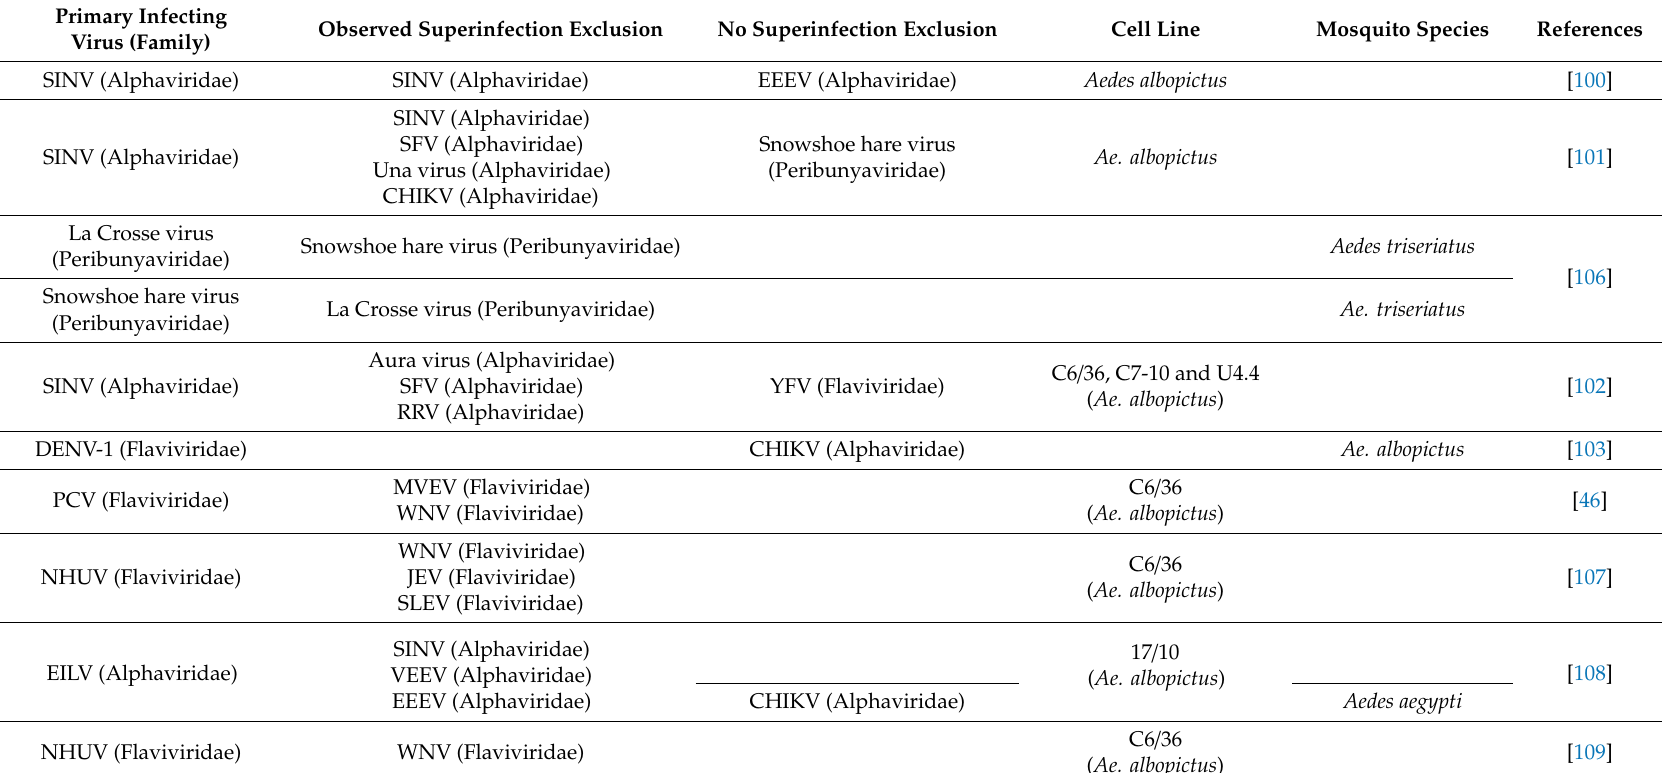
Table 1. List of published papers reporting superinfection exclusion and co-infection phenomena in Aedes mosquito cells and Aedes mosquitoes [46,99–104,106–110]. Viruses: SINV, Sindbis, CHIV; chikungunya, DENV, dengue, SFV; RVV; Ross River, PCV, MVEV, WNV, West Nile, NHUV, SLEV, St. Louis encephalitis, JEV, Japanese encephalitis, VEEV, Venezuelan equine encephalitis, EEV, Eastern equine encephalitis, YFV, yellow fever, ZIKV,